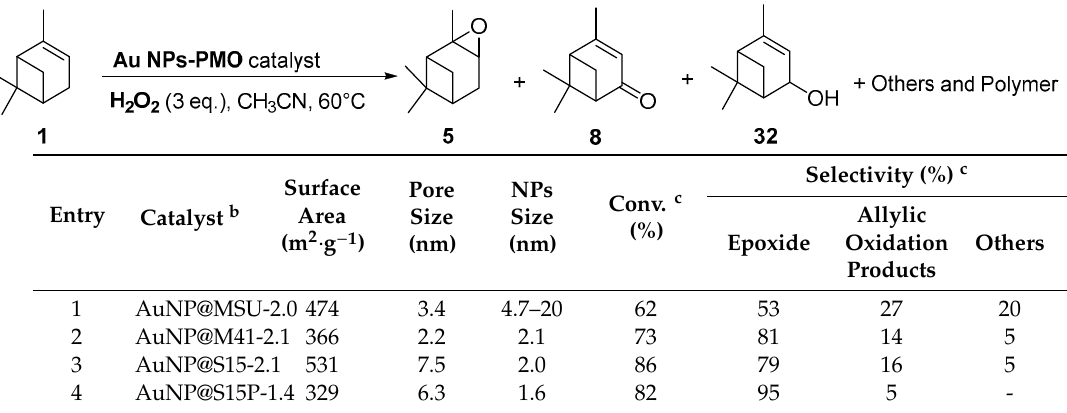
a Reaction Conditions: Catalyst (50 mg or 100 mg for S15P-1.4), α -pinene (10 mmol), H 2 O 2 (3